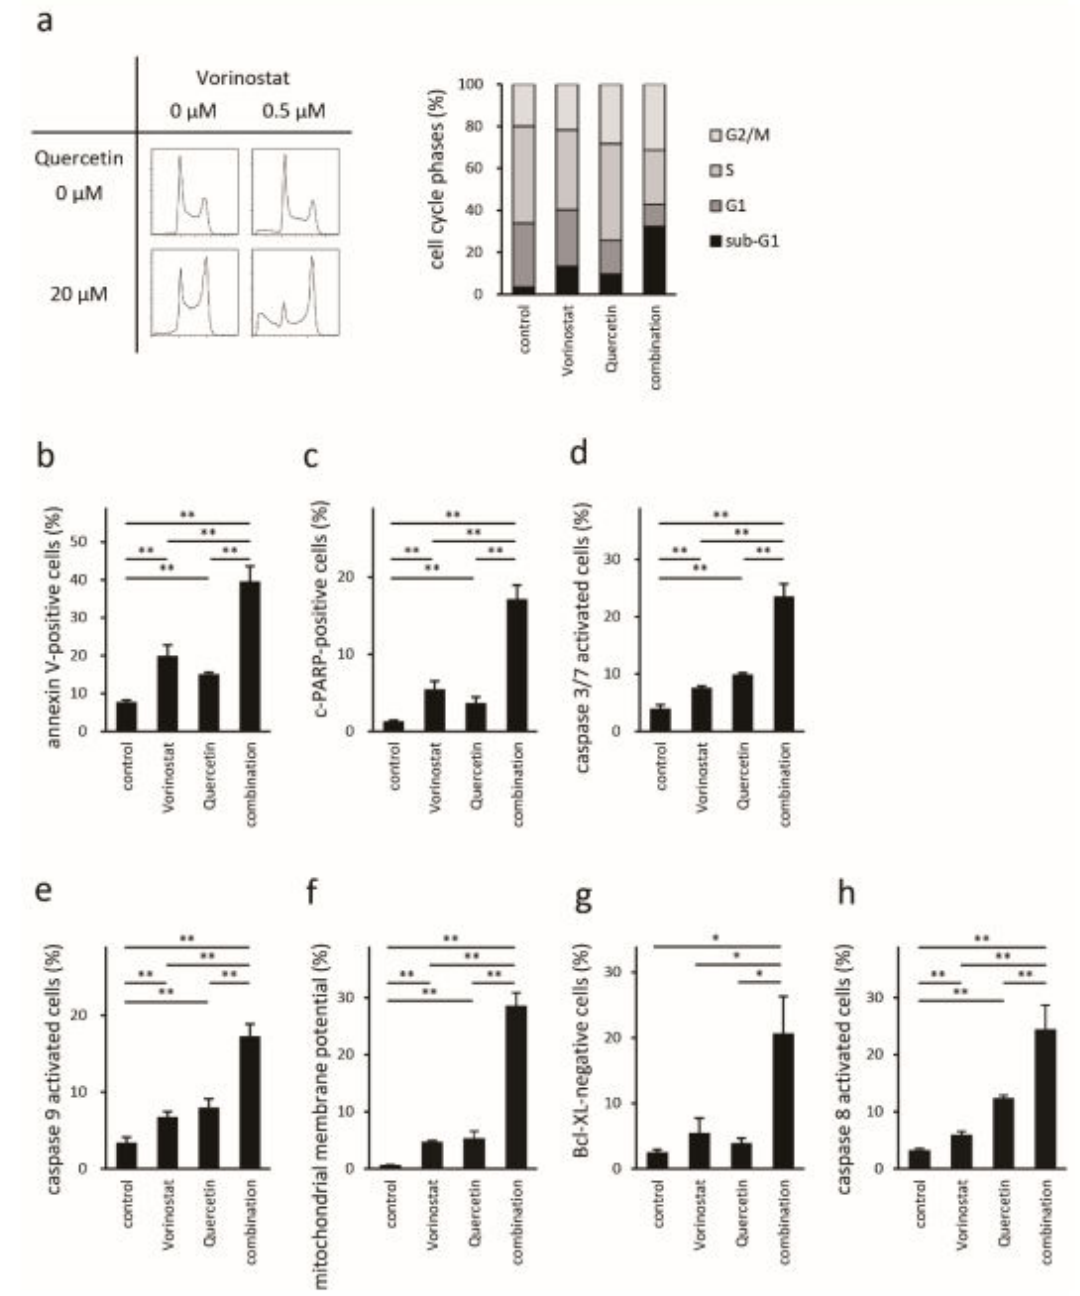
Figure 4. Assessment of the effect of quercetin on the antitumor effects of vorinostat in Hut78 cells. Propidium iodide staining ( a ). Representative images are shown in the left panels and the summary of the analysis is shown as a bar graph in the right panel. Annexin V assay ( b ); cleaved PARP assay ( c ); activated caspase-3/7 ( d ), caspase-9 ( e ), and caspase-8 ( h ) analysis; loss of mitochondrial membrane potential ( f ); bcl-XL expression ( g ) as assessed via FACS. * p < 0.05, ** p < 0.01 by Bonferroni t